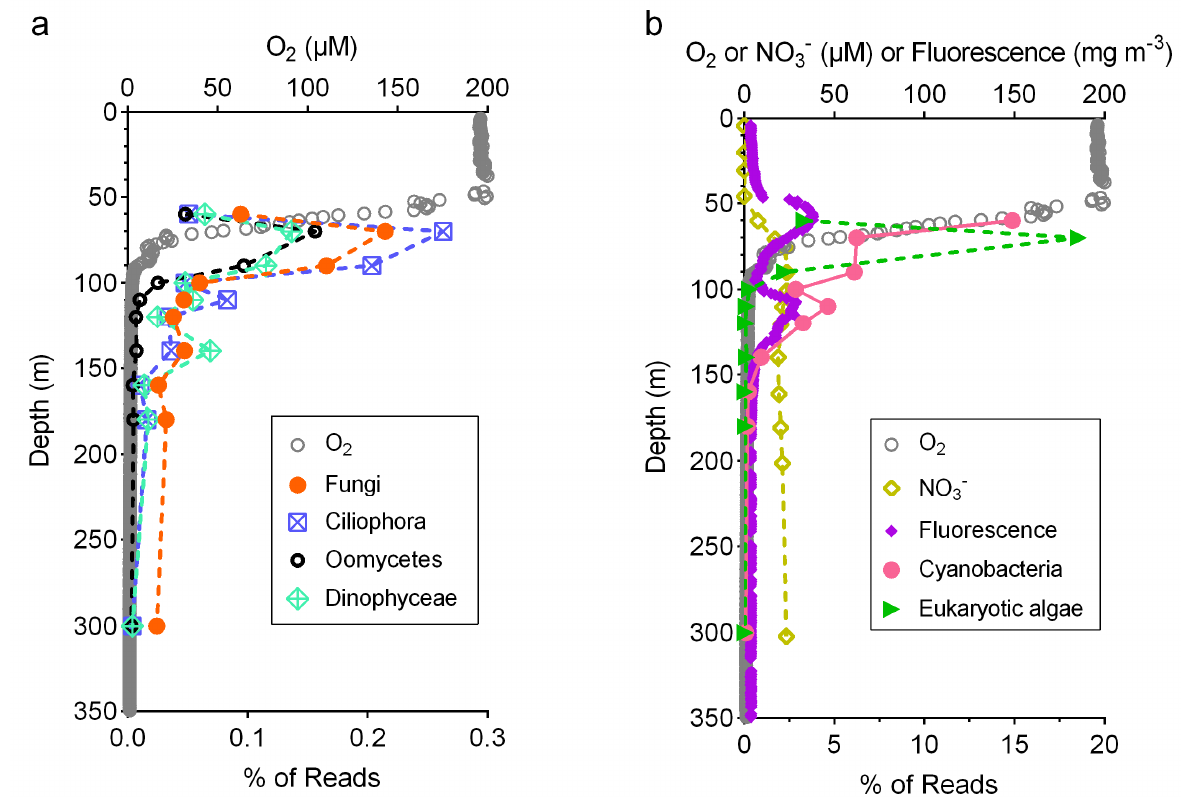
Figure 4. ( a ) Dissolved oxygen concentration ( µ M) and the relative abundance of reads classified as Fungi, Ciliophora, Oomycetes, and Dinophyceae from the metagenomes [37] collected from a location near Station 2 in this study; ( b ) dissolved oxygen concentration ( µ M), nitrate (NO 3 − ) concentration ( µ M), fluorescence (mg m − 3 ) [47], and the relative abundance of reads classified as Cyanobacteria and eukaryotic algae. Eukaryotic algae include Haptophyta, Bacillariophyta, Rhodophyta, Cryptophyta, and Viridiplantae.